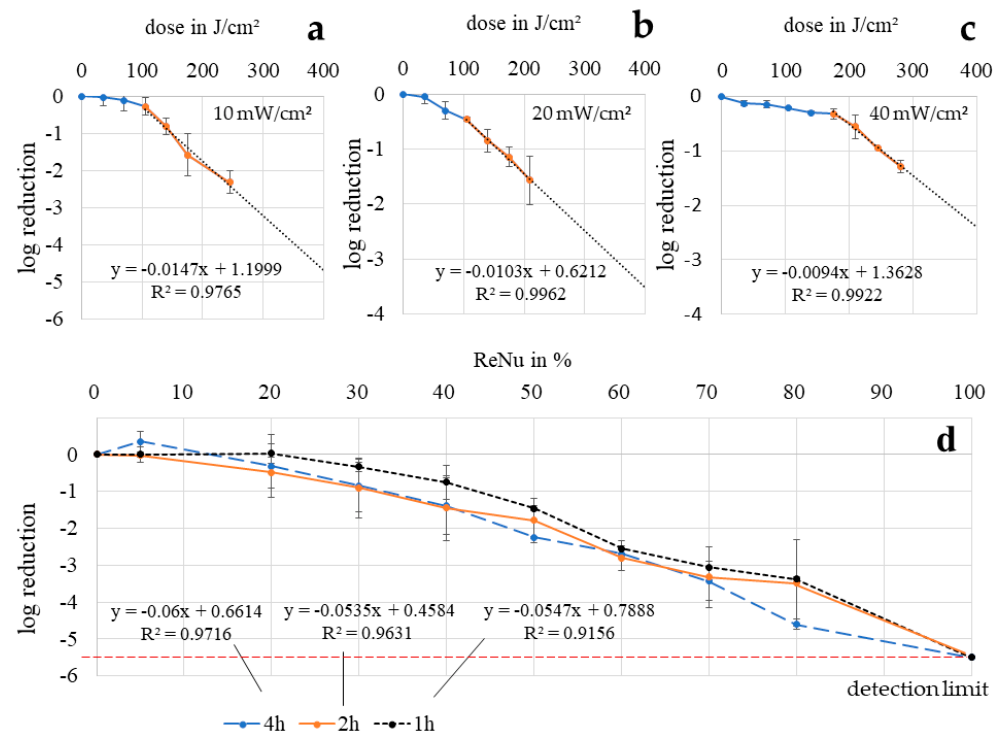
Figure 4. Reference experiments on agar plates to achieve dose-effect curves for single approaches on P. fluorescens : 405 nm irradiation in phosphate buffered saline (PBS) with 10 mW/cm 2 ( a ), 20 mW/cm 2 ( b ) and 40 mW/cm 2 ( c ) as well as ReNu Multiplus exposure for 1, 2, and 4 h at different concentrations ( d ). Error bars indicate the deviation in the two experiments.